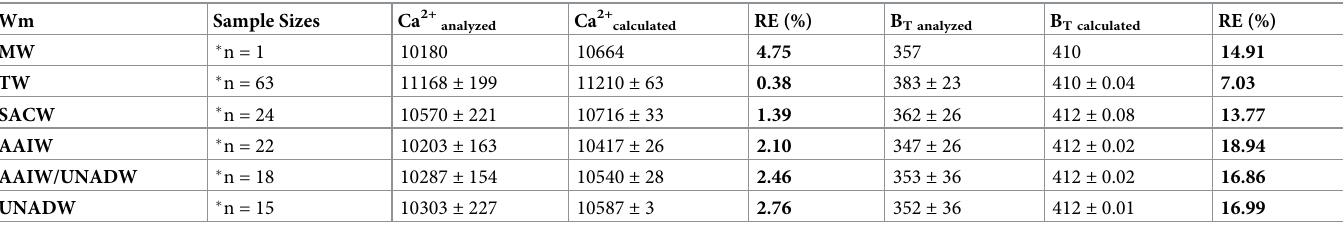
Table 5. Calcium and total boron concentrations ( μ mol/kg; mean ± standard deviation) in water samples from 34 stations. Analytically obtained levels: microwave- induced plasma atomic emission spectrometry. Predicted concentrations: calculated using the AQM program using the absolute salinity scale (g/kg). When calculating the relative error (RE%), the expected value is the analyzed